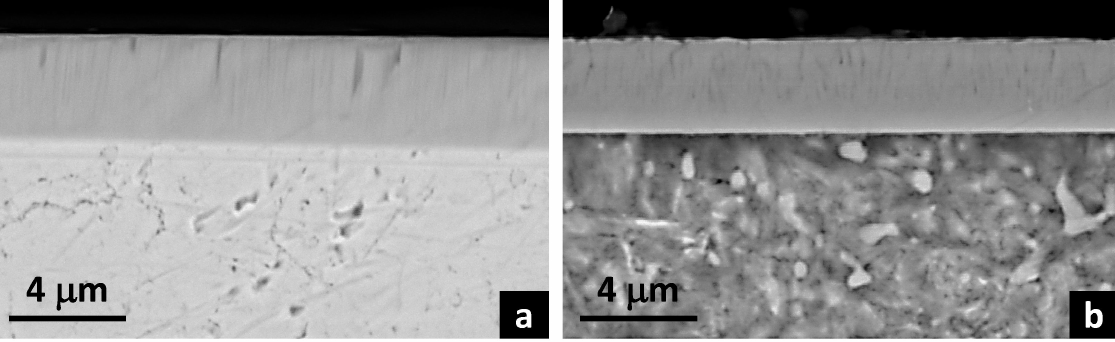
Figure 4. SEM image of the CrN coatings on the simply coated ( a ) and duplex-treated ( b ) samples. The composite hardness of the coated systems was 632 ± 61 HV 0.5 for the simply coated and 1250 ± 204 HV 0.5 for the duplex-treated